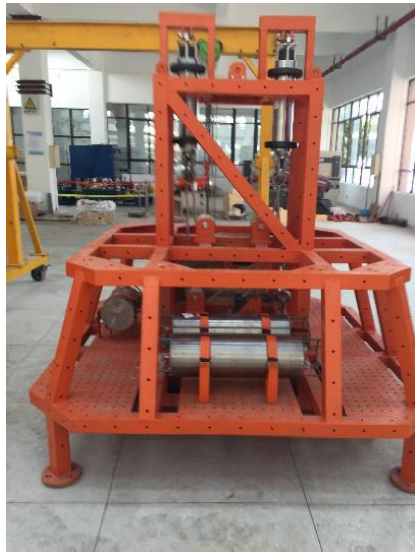
Figure 6. Mechanical design of the Benthic Observation Node.